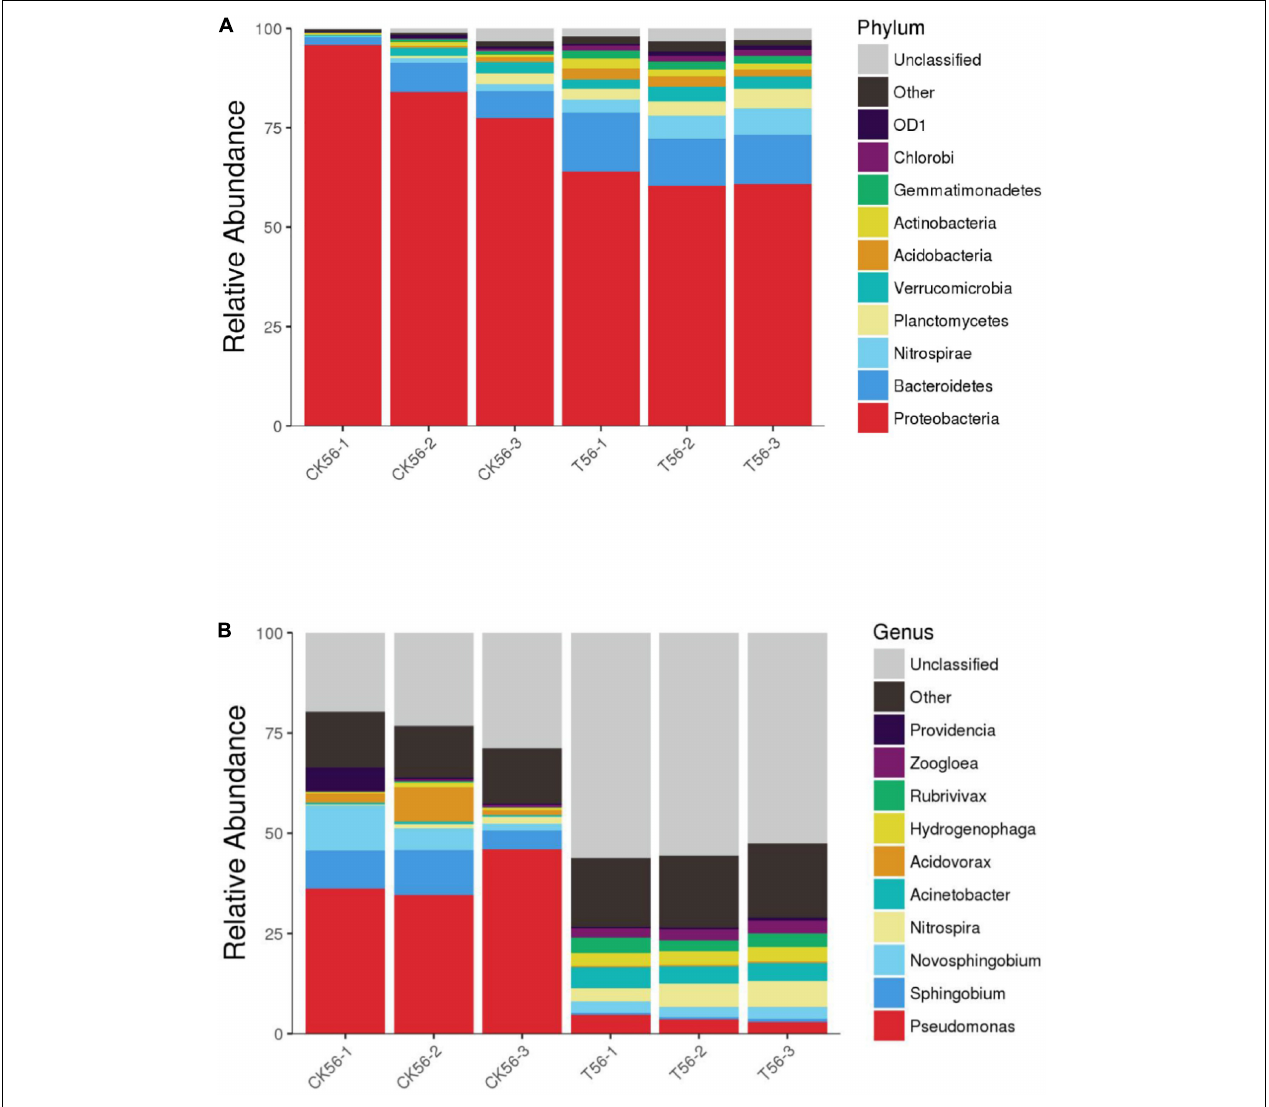
FIGURE 8 | Diversity and composition of the bacterial community in the PHPS filter at the phylum (A) and genus (B) level on day 56. Phyla or genera with relative abundances of less than 0.1% were classified as